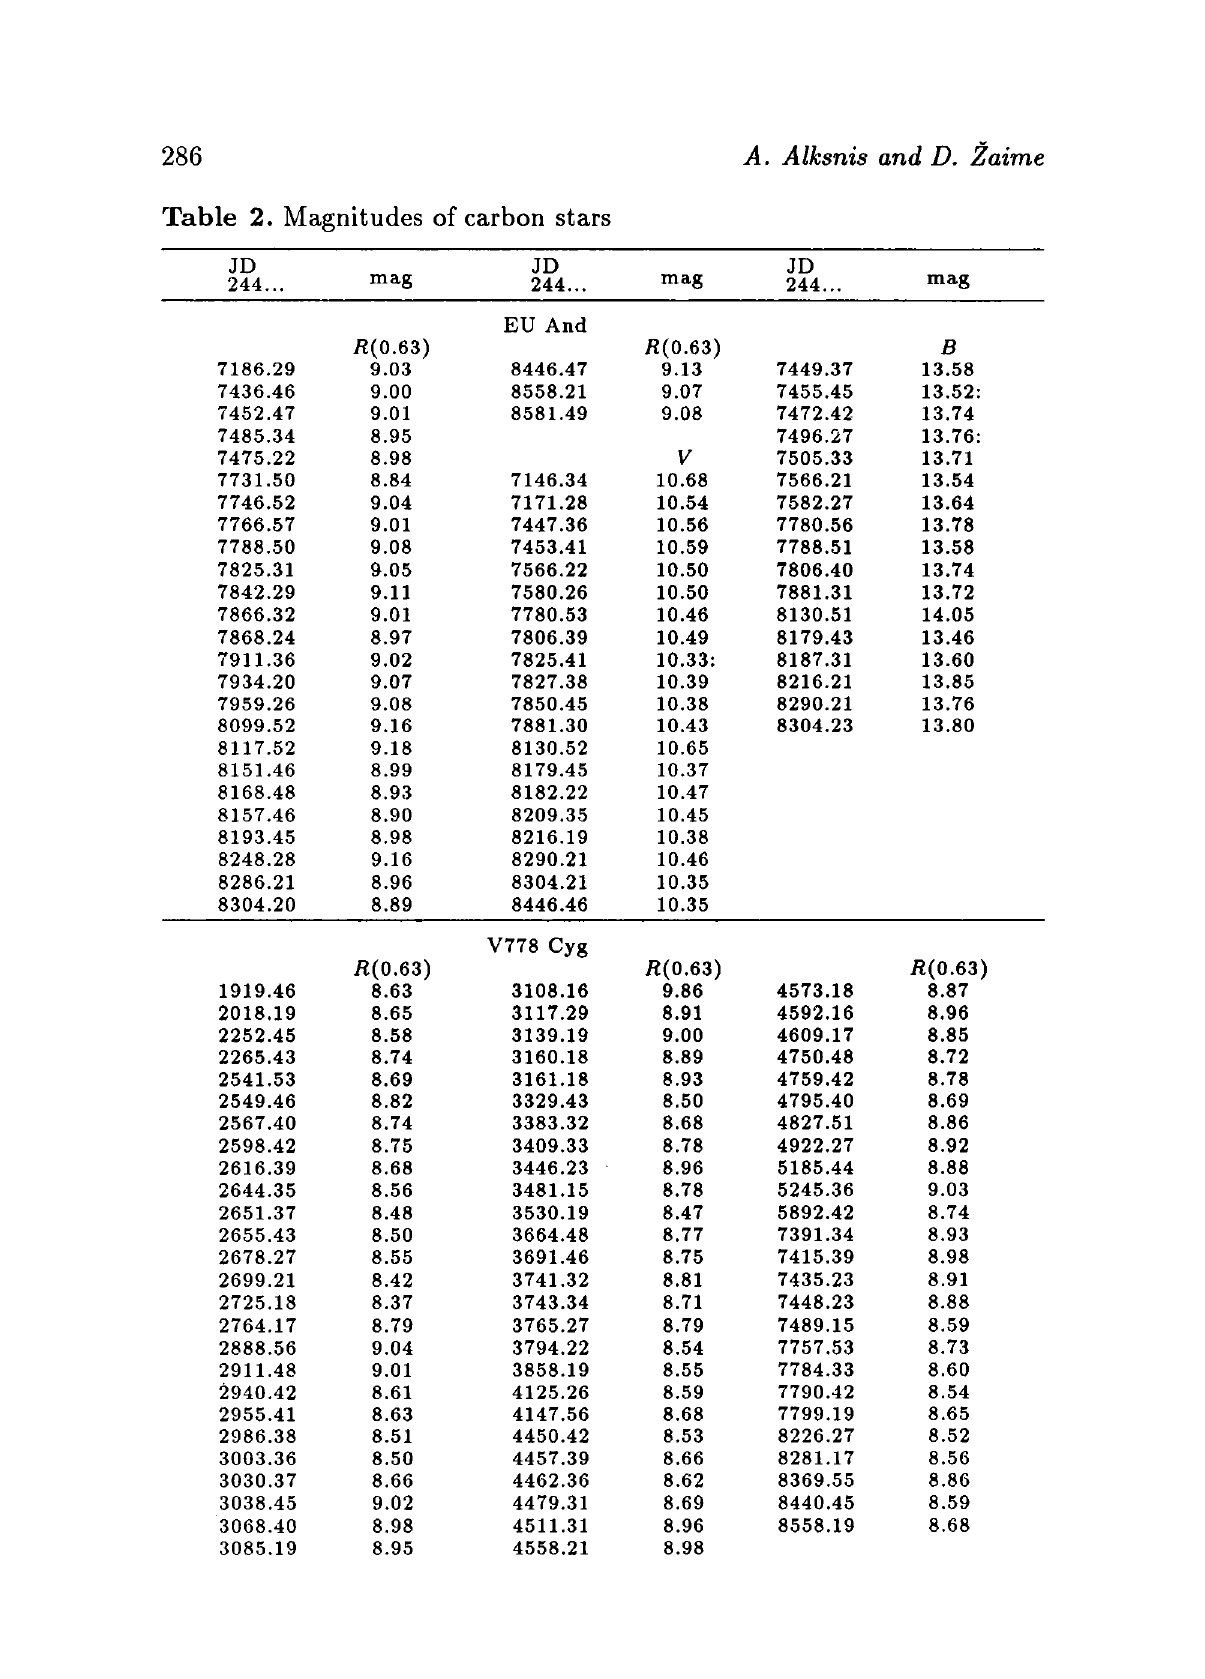
Table 2. Magnitudes of carbon